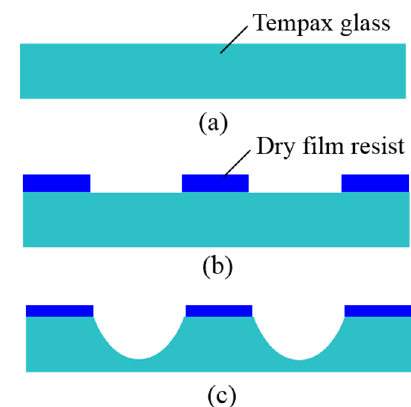
Figure 2. Fabrication process. ( a ) Tempax glass; ( b ) photolithography; ( c ) sandblast.